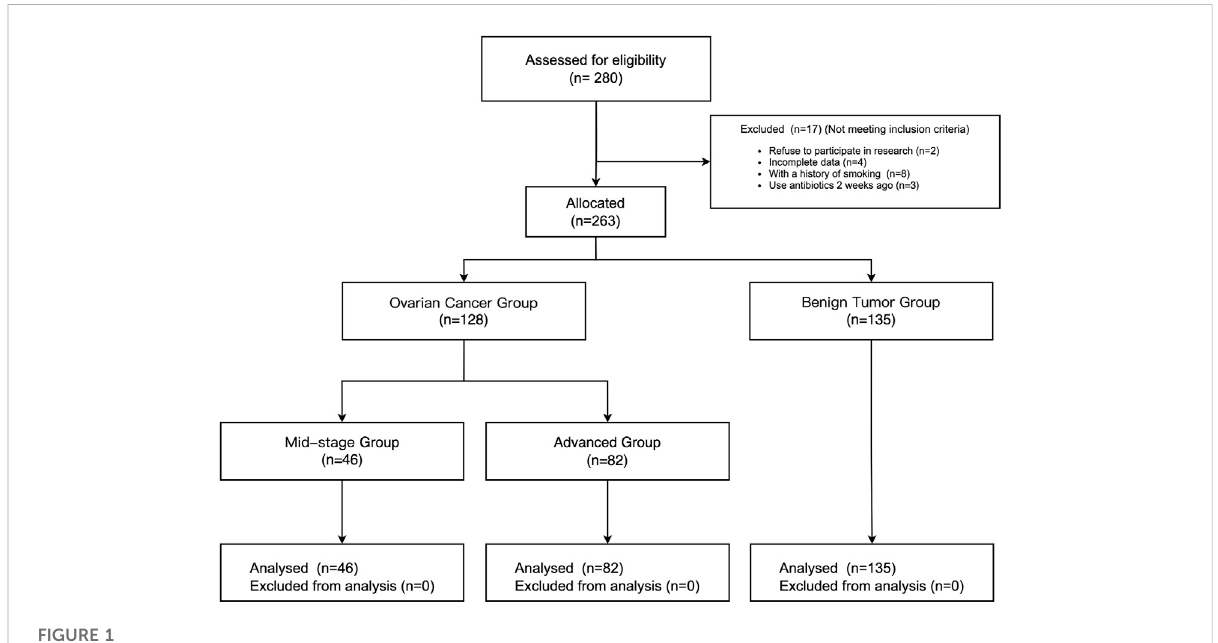
FIGURE 1 The fl ow chart of patient